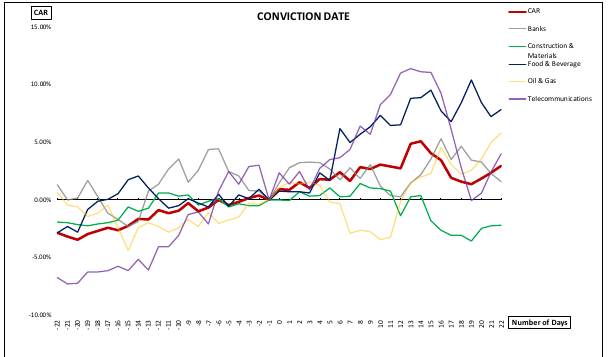
Figure 2: Cumulative abnormal returns around the announcement date of a conviction of collusion by the tribunal